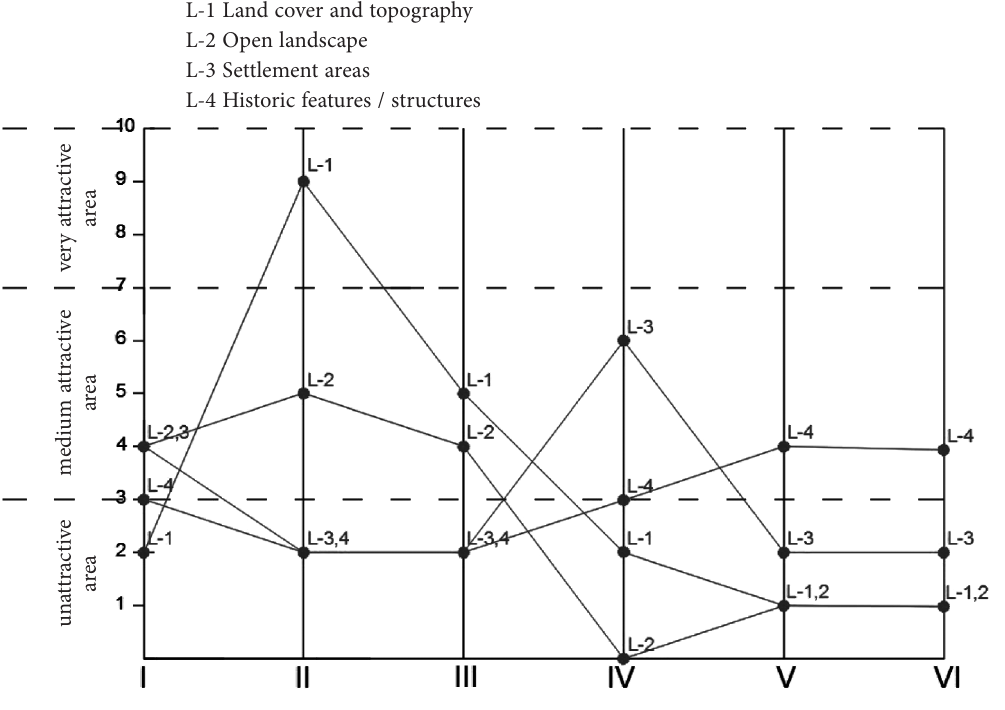
Figure 4. Values for landscape elements (L) in the LSHM Method assessment of the Skawinka river